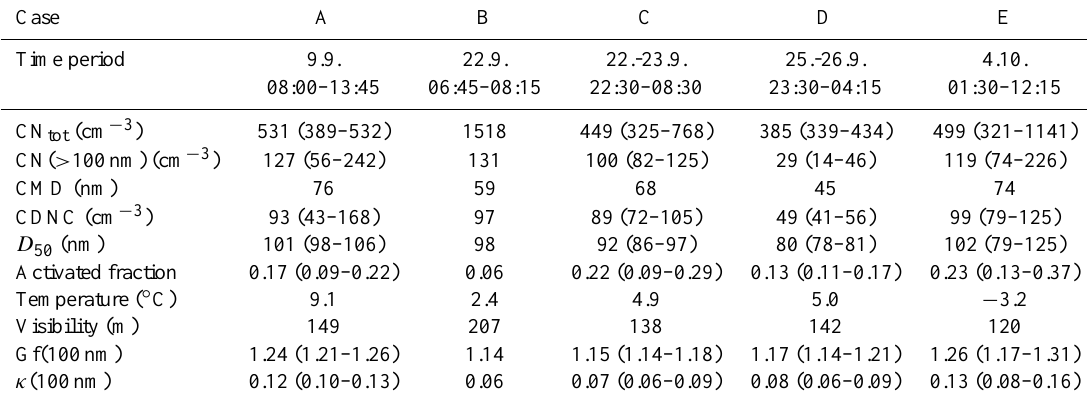
Table 1. Observed features of the analyzed cloud events. For each event, an average value of the quantity is shown, followed by the ranges in parentheses which represent the minimum and maximum values. Here CN tot is the total particle number concentration, CN( > 100nm) is the concentration of particles with dry sizes above 100nm, CMD is the count mean diameter of the size distribution, CDNC is the inferred number of cloud droplets and D 50 is the diameter corresponding to the 50% activation efficiency. Moreover, estimated hygroscopic growth factors at 90% RH for particles having a dry size of 100nm, Gf (100nm), are shown along with the corresponding values of the hygroscopicity parameter κ (calculated according to Petters and Kreidenweis, 2007), κ (100nm). The values of κ were calculated at temperature of 298 K and under the assumption that the droplet surface tension equals that of